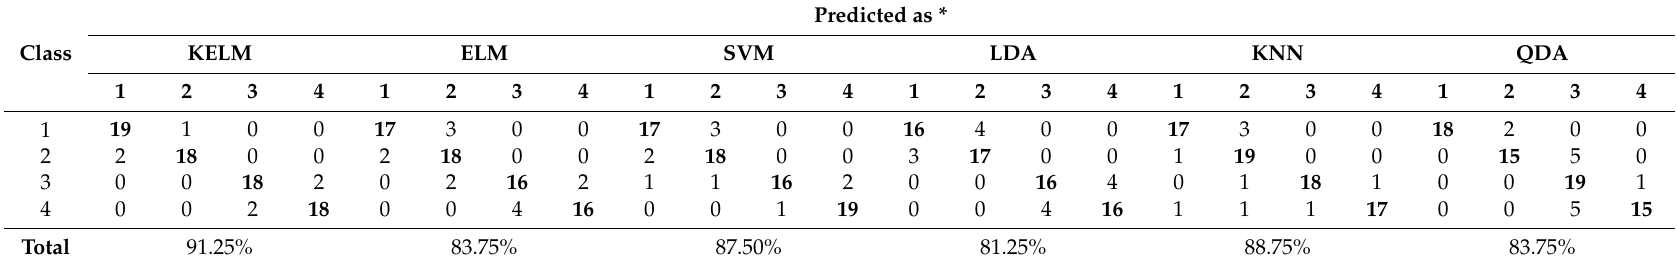
Table 3. Classification results of Fourier coefficients.